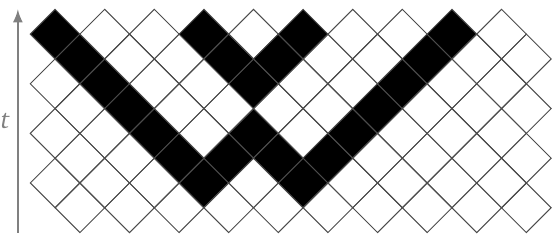
⊗ 5 ⊗ | ⊗ 6 Figure 4: Time-evolution of | 0 〉 010 〉 ⊗ | 0 〉 ⊗ | 010 〉 ⊗ | 0 〉 . Up to the even-odd staggering, the horizontal coordinate of a diamond corresponds to the physical site, the vertical position indicates the time-step (increasing upwards). Black diamonds correspond to | 1 〉 s and white ones to | 0 〉